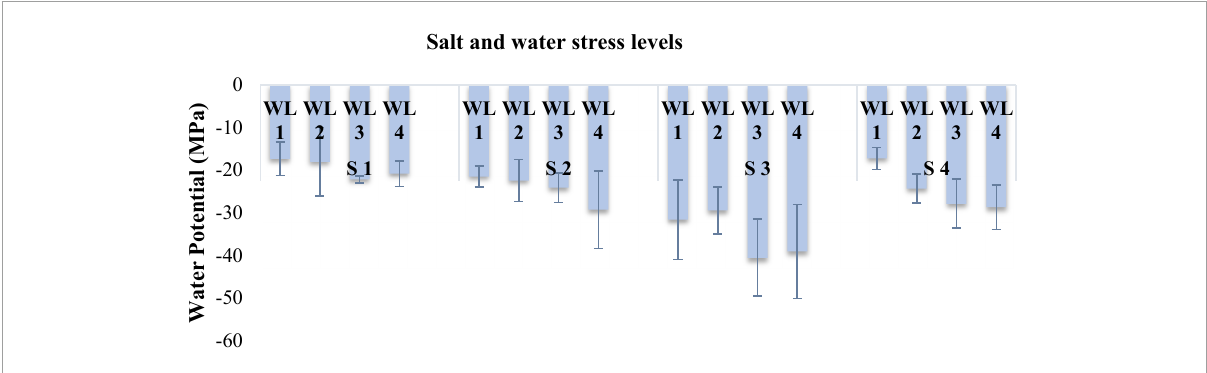
FIGURE3 Interactive effect of salinity and drought stress on water potential (MPa) of Atriplex leucoclada . The error bars represent the standard error of the mean ( n = 3). WL stands for water level (WL1 = 100% field capacity, WL2 = 80% field capacity, WL3 = 60% field capacity and WL4 = 40% field